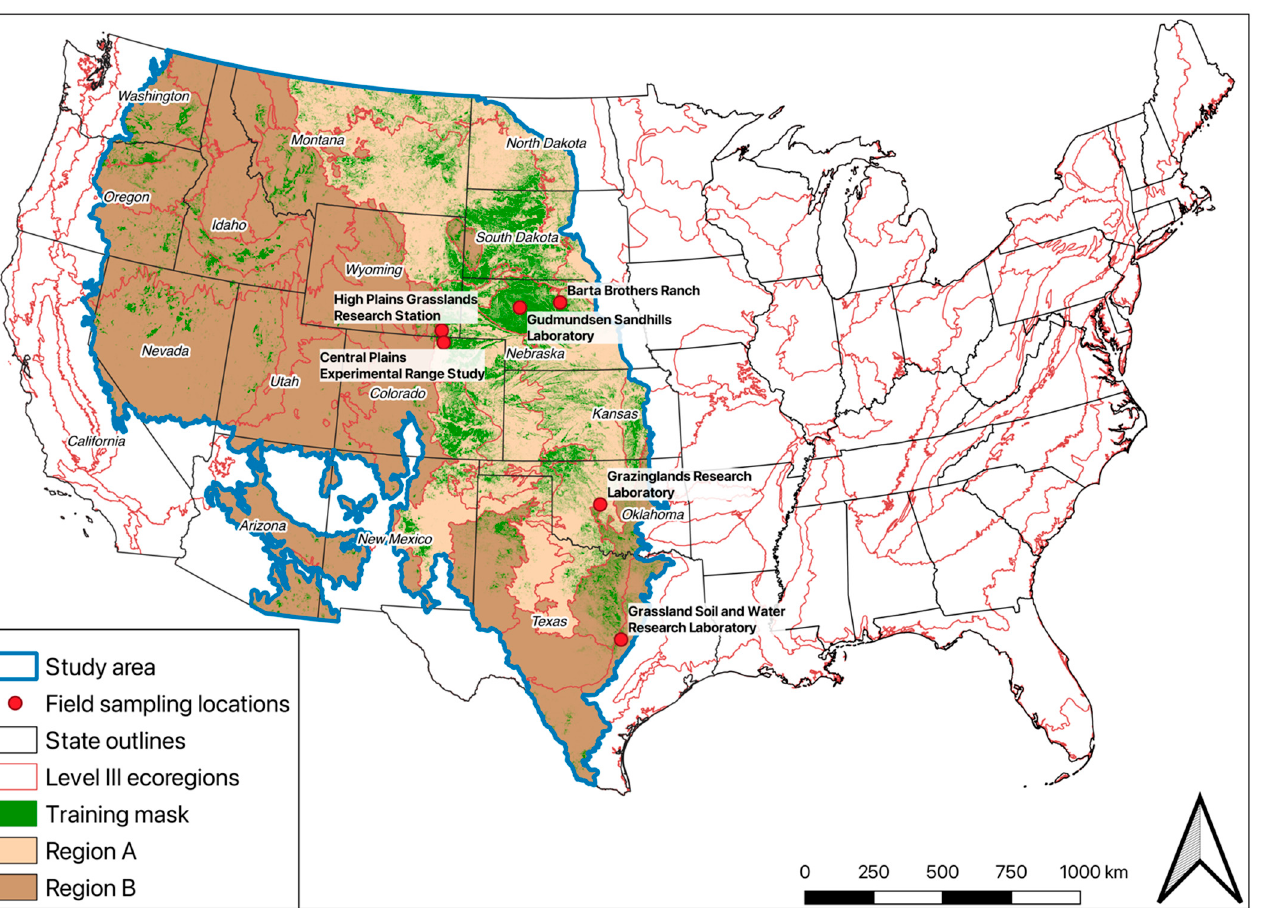
Figure 1. Location of the study area. Region A represents the Great Plains with higher percentage of herbaceous cover, while Region B represents the southern and western areas with much lower total herbaceous cover. The green areas display the distribution of areas that were identified as suitable for placement of model training points. Locations of ground-based validation are displayed as red dots.